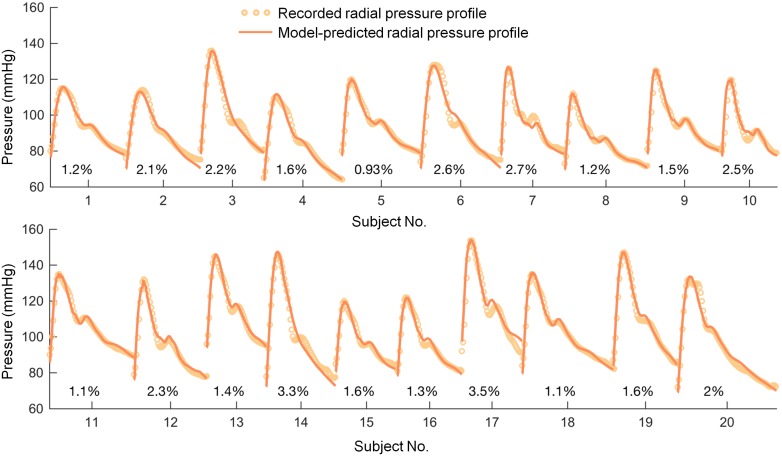
Comparison of pressure waveforms in radial artery recorded using SphygmoCor (circles) with the fitted model curves (solid lines) for 20 healthy volunteers.Shown are also mean absolute percentage errors for each subject separately. Summary of parameters used in the simulations is presented in Table 3.